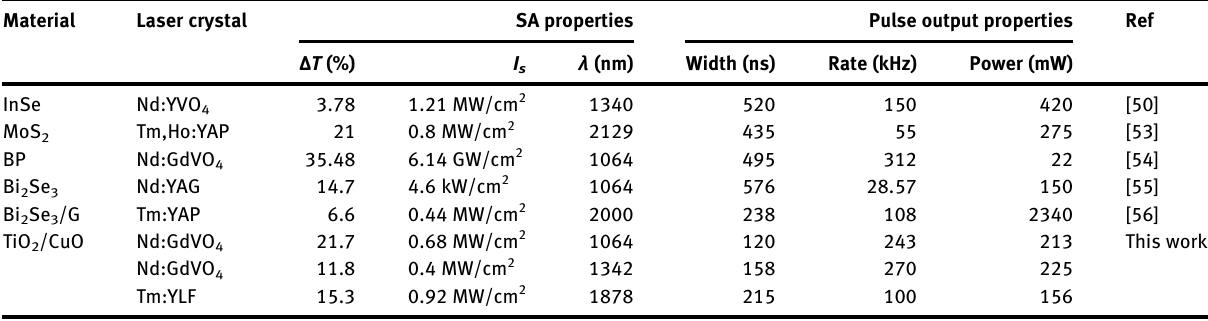
Table  : Broadband performance comparison of PQS bulk lasers with different NLO materials. Material Laser